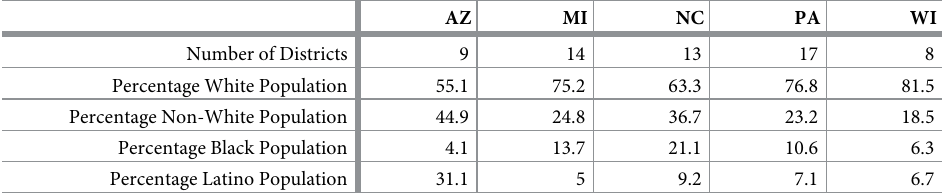
Table 5. Overview of congressional districts and white/ non-white population per considered state. AZ MI